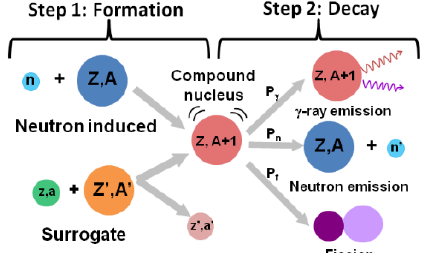
Fig. 1. Sequence of a neutron-induced reaction. First a compound nucleus is formed, which then de- excites by the emission of  rays, a neutron or by fission. The probability P associated to each decay channel is indicated. In a surrogate reaction, the same compound nucleus as in the neutron-induced reaction is produced by a different